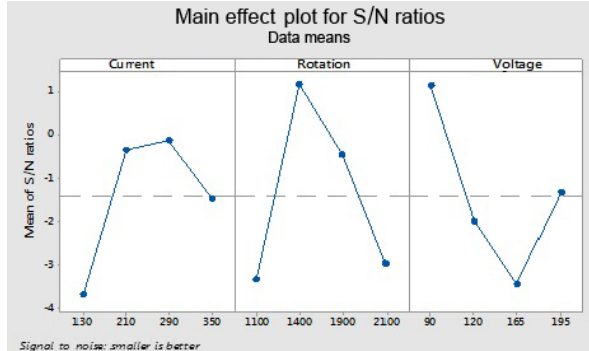
Figure 7. OC S/N ratio for non-cryogenic